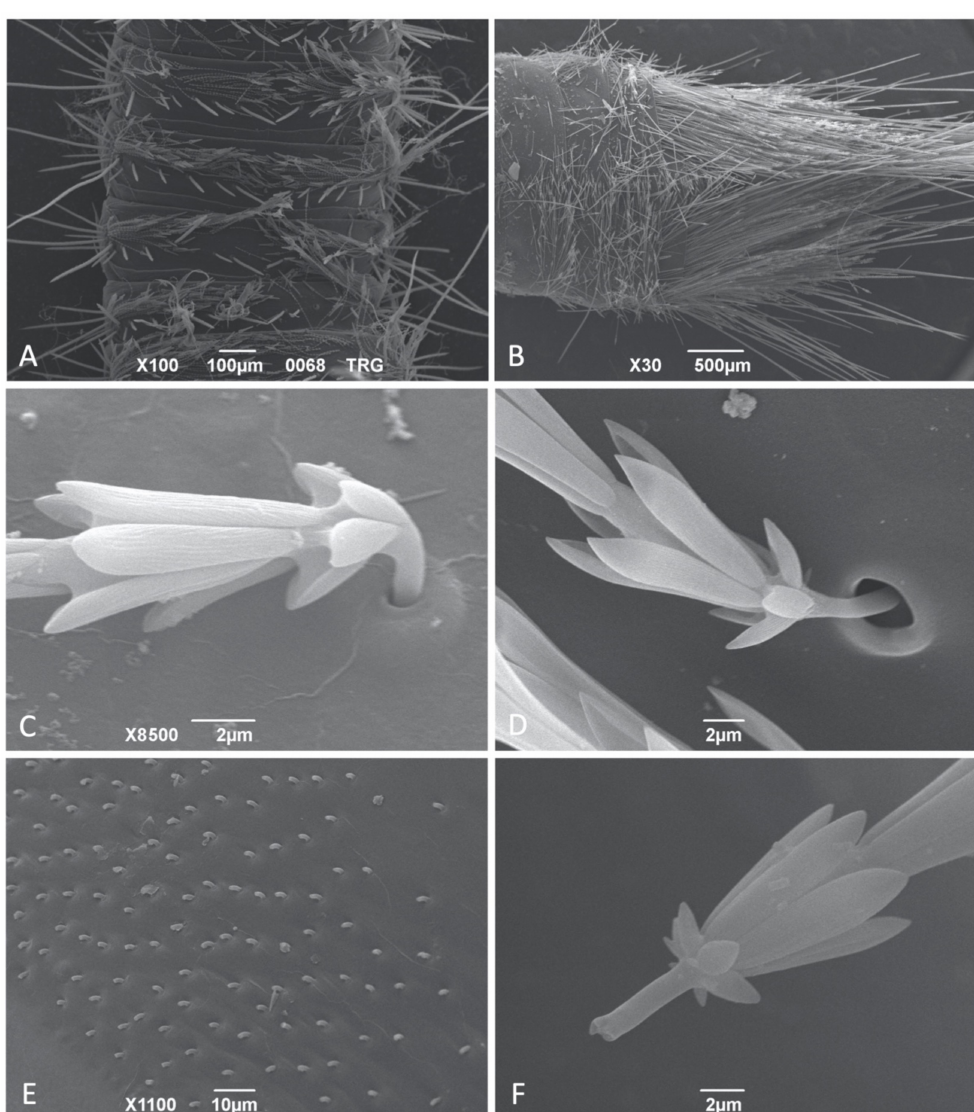
Figure 1. SEM photos of Megatominae larvae: ( A ) Dorsal view of the abdominal segments of Trogoderma spp. 3; ( B ) Dorsal view of the last abdominal segments of Ctesias serra ; ( C ) Trogoderma versicolor , detail of the pedicel and insertion on the tergite; ( D ) Ctesias serra , detail of the insertion of the hastiseta on the tergite; ( E ) Trogoderma spp. 2, series of broken pedicels remaining after the detachment of one tuft of hastisetae; ( F ) Ctesias serra , detail of one detached hastiseta showing the breaking point on the